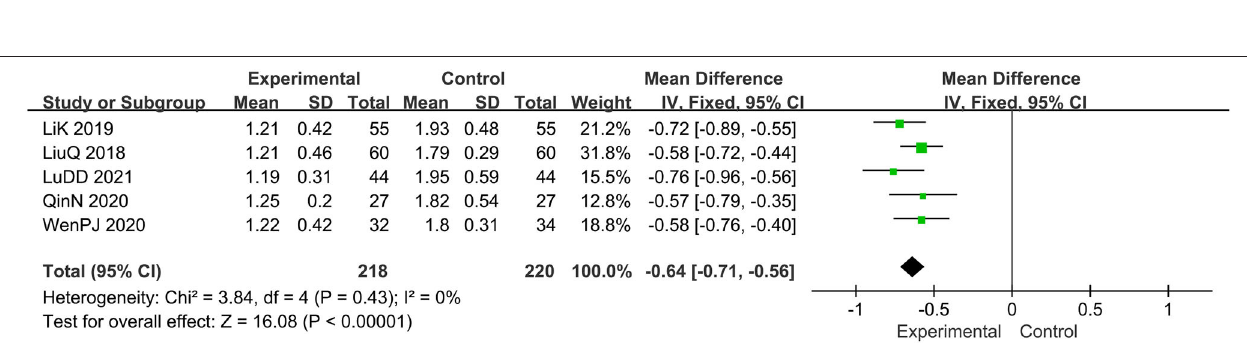
FIGURE 6 | The meta-analysis for comparison of combination therapy vs. prednisone for the outcome of the score of pruritus.